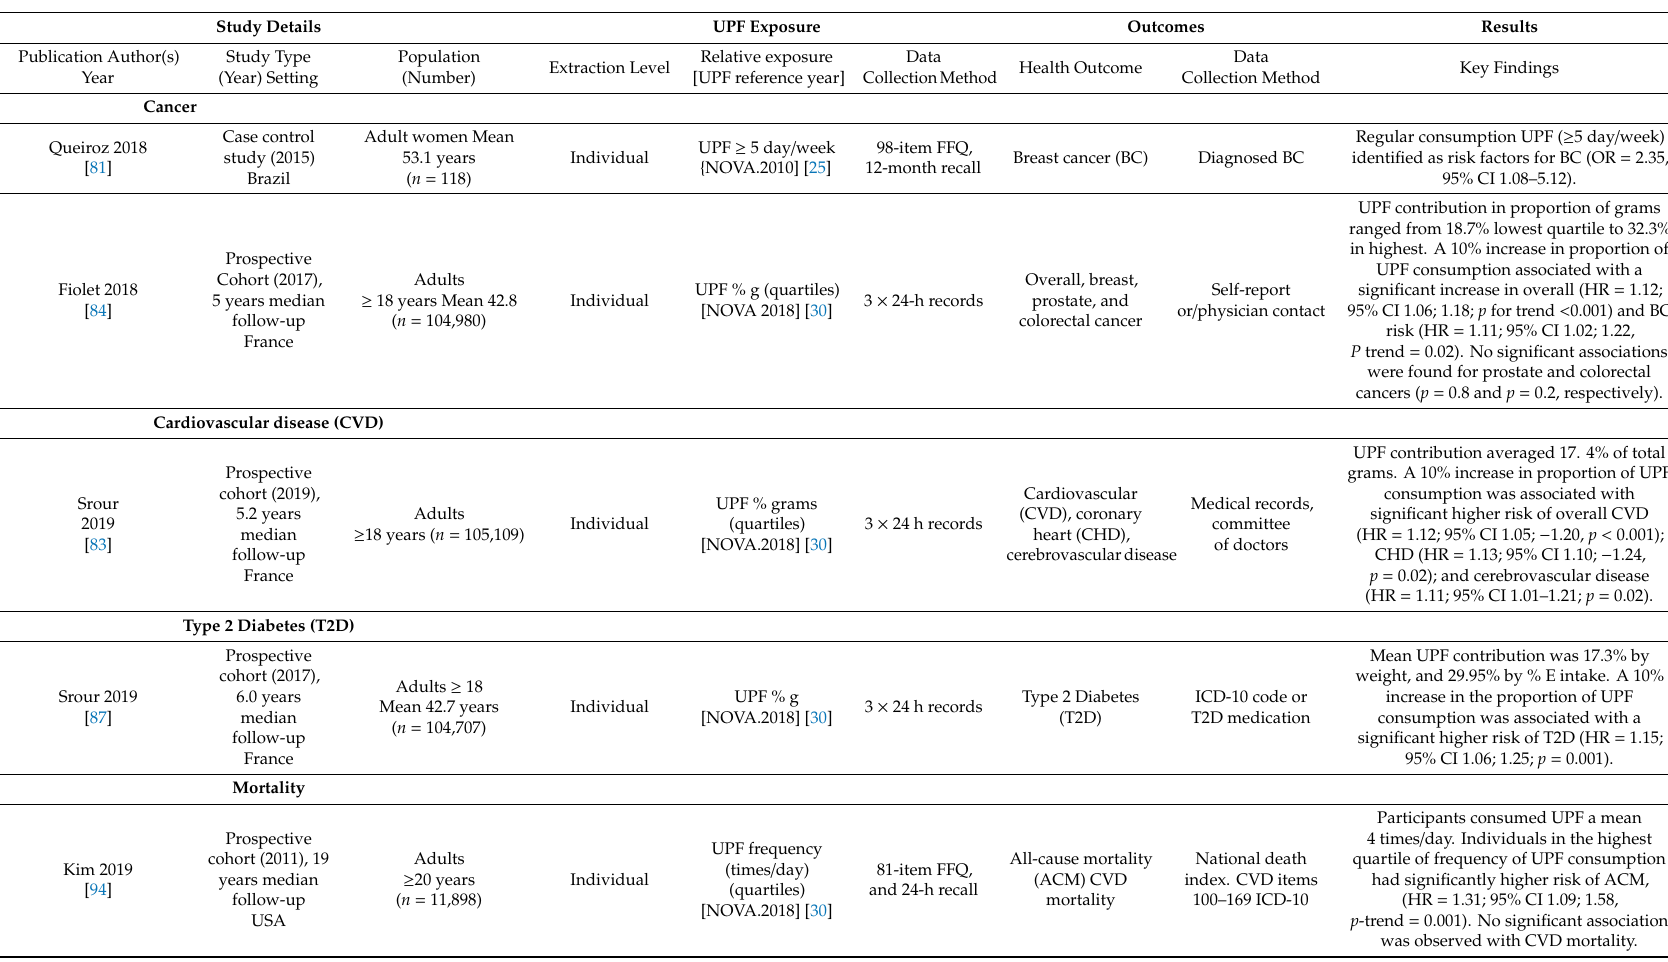
Table 4. Diseases and mortality as